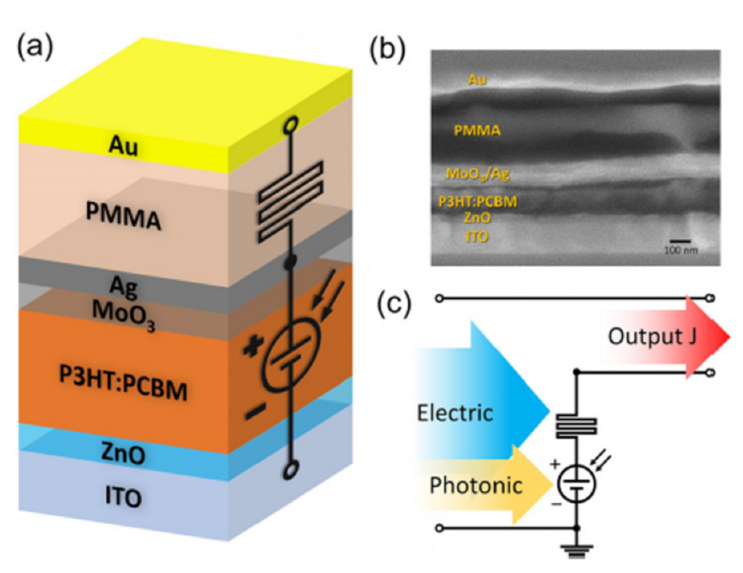
Figure 20. ( a ) OPT device structure, ( b ) the cross-sectional FESEM image and ( c ) the equivalent circuit of the device. Reprinted with permission from ref. [156]. Copyright 2019 AIP